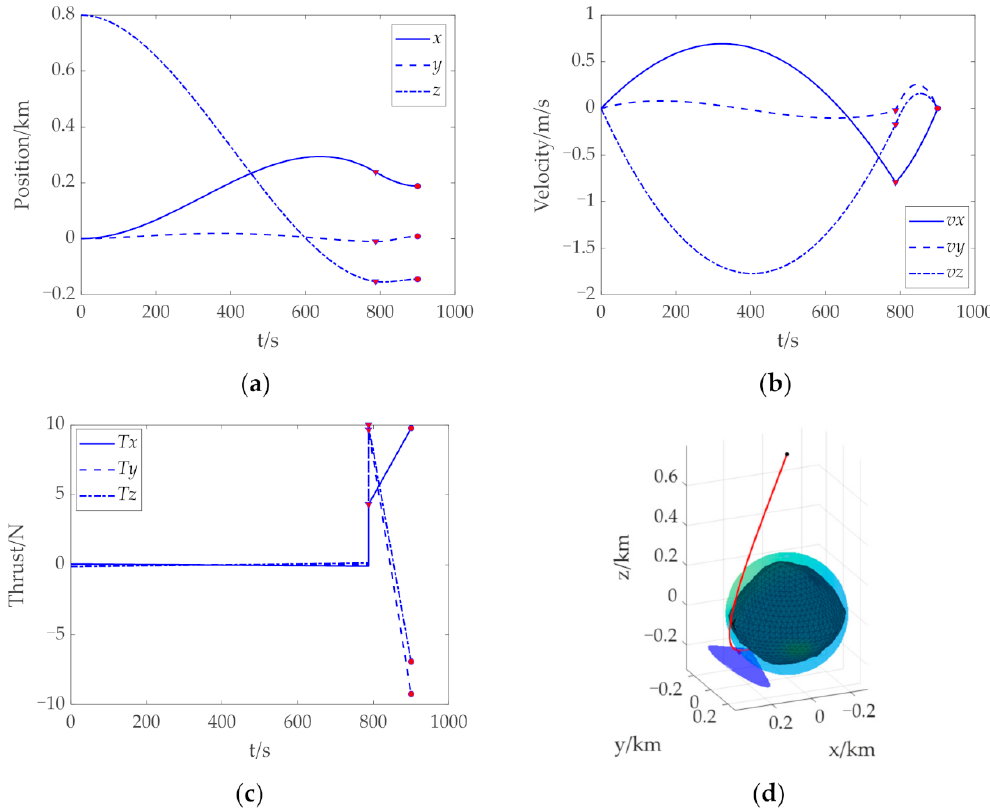
Figure 6. Trajectory optimization results of landing on the asteroid Bennu from above the North Pole. ( a ) Histories of the position. ( b ) Histories of the velocity. ( c ) Histories of the thrust. ( d ) History of the descent trajectory. The red “ ∆ ” and “ • ” indicate the transition position and landing position, respectively. “ • ” indicate the transition position and landing position,